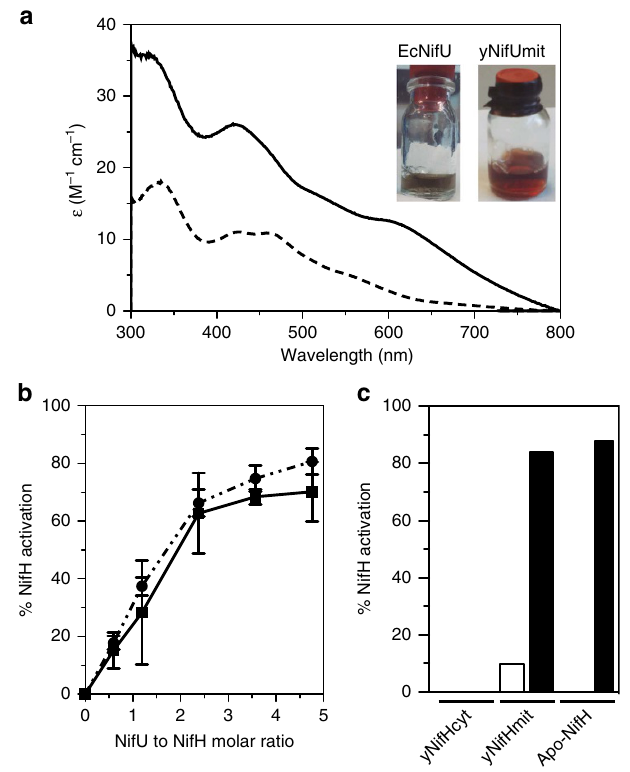
Figure 3 | Characterization of purified yNifUmit. ( a ) Purified preparations and ultraviolet–visible spectra of yNifUmit (190 m M, broken line) and EcNifU (190 m M, solid line). ( b ) Titration of apo-NifH activation by yNifUmit (broken line; n ¼ 4) or EcNifU (solid line; n ¼ 2). Data represent means ± s.d. All assays contained 5 m M apo-NifH (162 m g) in the Fe-S cluster reconstitution phase. Fully active Fe protein supported MoFe protein specific activity of 2,200nmol ethylene (cid:2) per minute (cid:2) per milligram MoFe protein (corresponding to 100% activity). ( c ) Activation assays of yNifHmit (40 m g) and yNifHcyt (80 m g) with a 5-fold molar excess of yNifUmit. The yNifHmit and yNifHcyt proteins were purified from aerated cultures (1 litre air (cid:2) per minute per litre of culture) of GF2 and GF9 strains, respectively. In vitro generated A. vinelandii apo-NifH (80 m g) was used as control of activation reactions. MoFe protein-specific activity supported by fully active Fe protein under same assay conditions was 1,480nmol ethylene (cid:2) per minute per milligram MoFe protein (corresponding to 100% activity). Empty bar represents the Fe protein activity of purified yNifHmit before the yNifUmit-dependent activation assay. Non-activated A. vinelandii apo-NifH and yNifHcyt lacked Fe protein activity. yNifUmit was unable to endow yNifHcyt with Fe protein